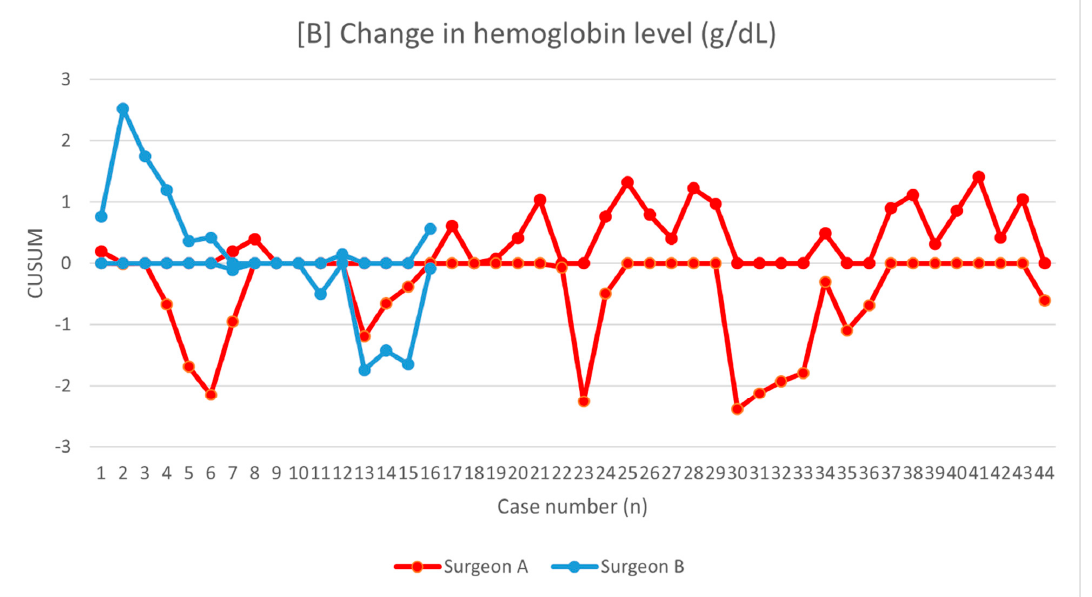
Figure 3. Chart showing the change in hemoglobin level presented as cumulative sum analysis separately for surgeons A and B.